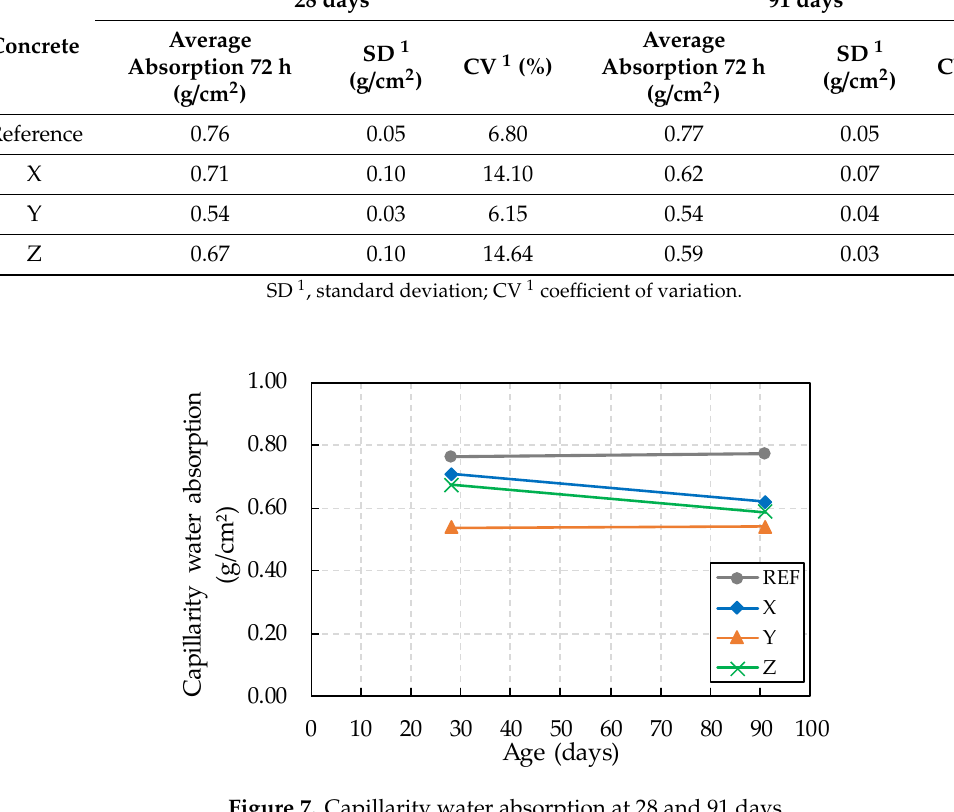
Table 7. Capillarity water absorption at 28 and 91 days.